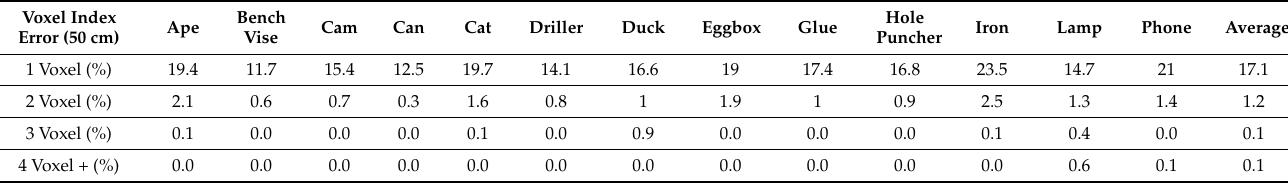
Table 5. Distance error comparison for voxel size (50 cm).